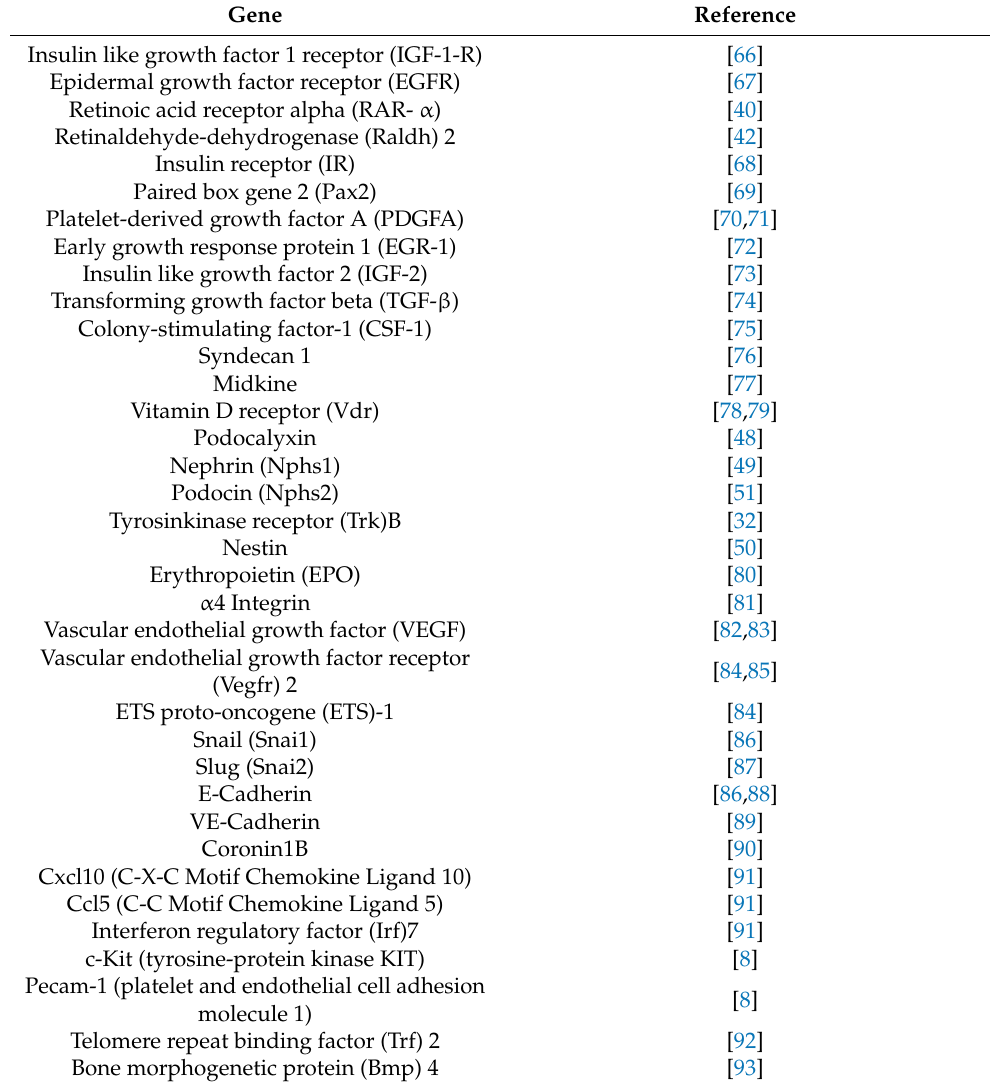
Table 2. WT1-target genes related to cardiac development and